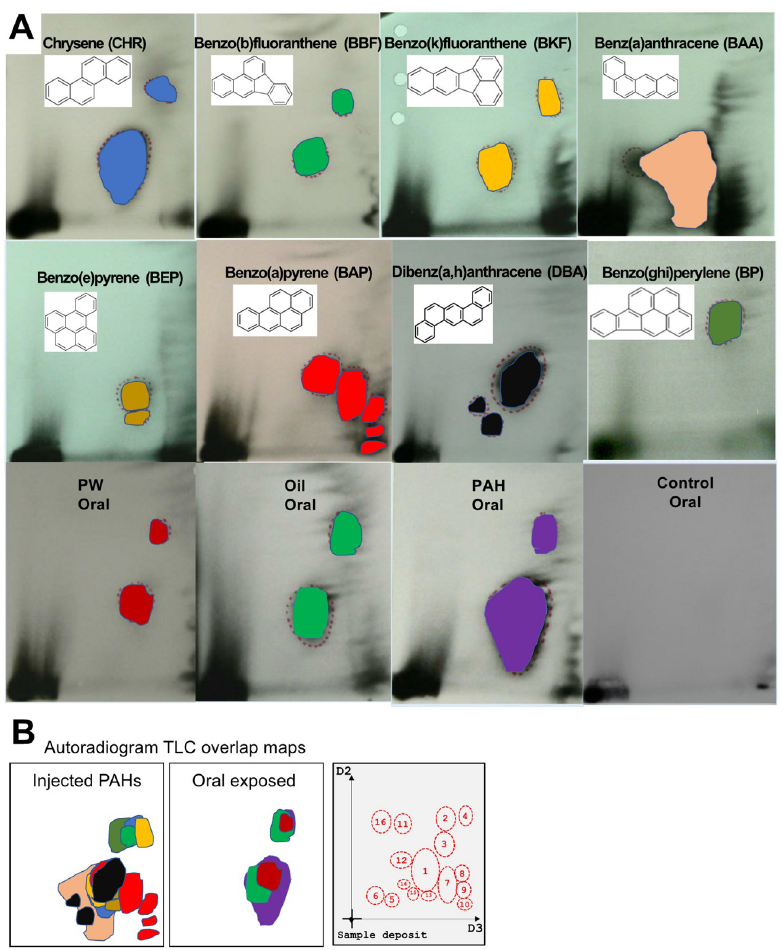
Fig 5. A. Representative autoradiogram of TLC maps in liver of haddock injected with single PAHs or exposed orally through feed for mixtures of PAHs ( PW , Oil , PAH , Control). B. Overlap maps of the TLC spots from the different injected single compounds and the oral mixtures. 16 different spots from all the 384 plates (192 samples) analysed in this project were identified. https://doi.org/10.1371/journal.pone.0240307.g005 The PAH treatment group, with only 4/5/6-ring PAHs, had elevated amounts of both 4-ring pyrene type and 5- and 6-ring BAP type PAH metabolites already after 3 days and one single oral dose. After 67 days of exposure, only the 4-ring pyrene-type metabolite concentra- tion was higher than control. Elevated levels of bile metabolites were not recorded in the recov- ery period. For the PW treatment group, we observed a trend, albeit insignificant, of higher average levels of the 2- and 3- ring type metabolites compared with control at 10, 37 and 67 days exposure. Table 4. Frequencies of the total number of samples in each treatment groups with detectable levels of the three dominating spots (1, 3 and 5). Control group PW group Oil group PAH